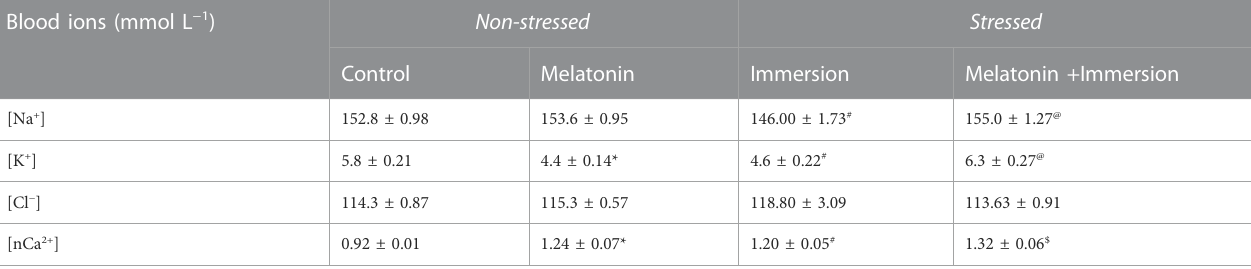
TABLE 3 Action of melatonin (50 ng g − 1 ) for 30 min on blood ions in non-stressed and immersion-stressed A . testudineus . Blood ions (mmol L − 1